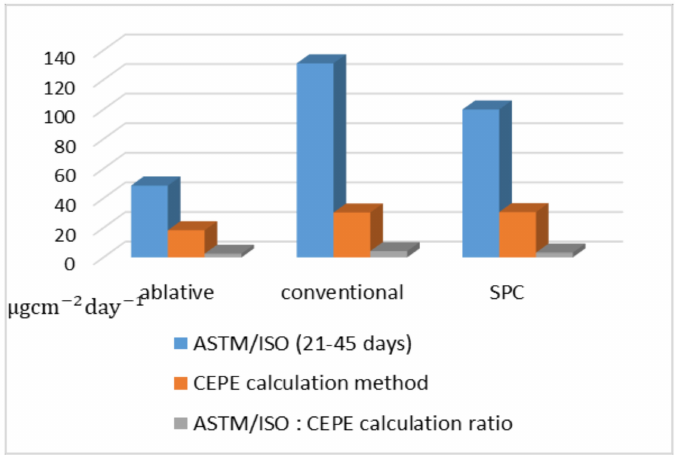
Figure 2. Copper emissions of ablative, conventional and SPC type of AF